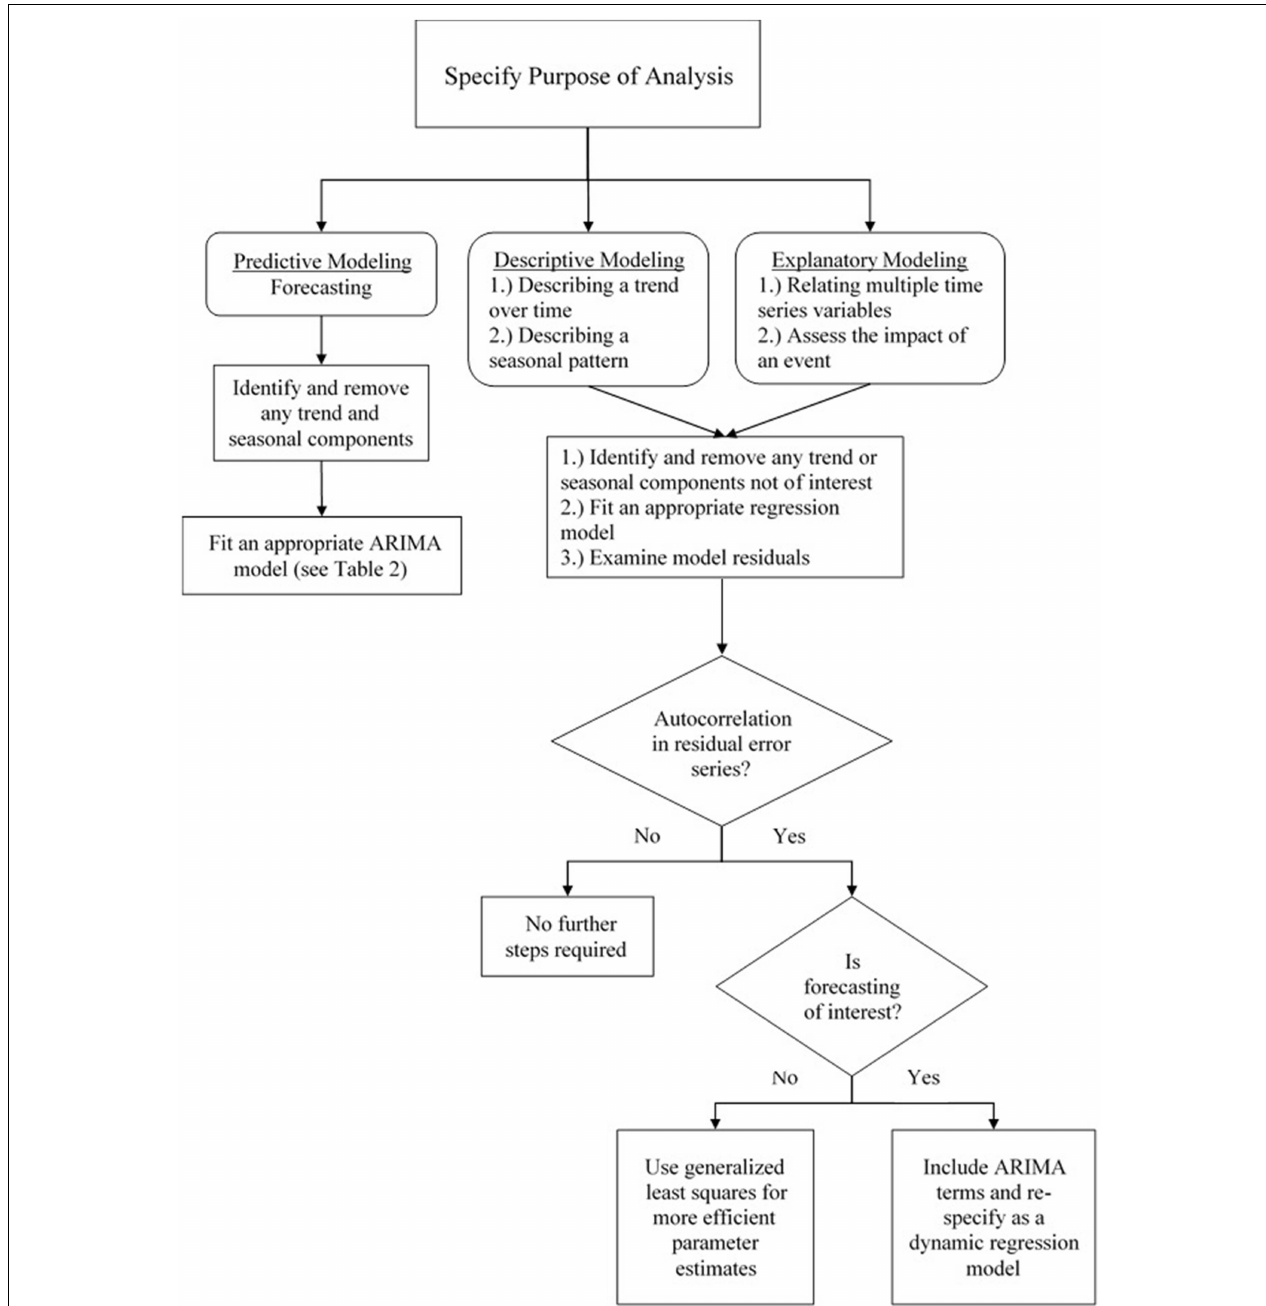
FIGURE 5 | A flowchart depicting various time series modeling approaches and how they are suited to address various goals in psychological